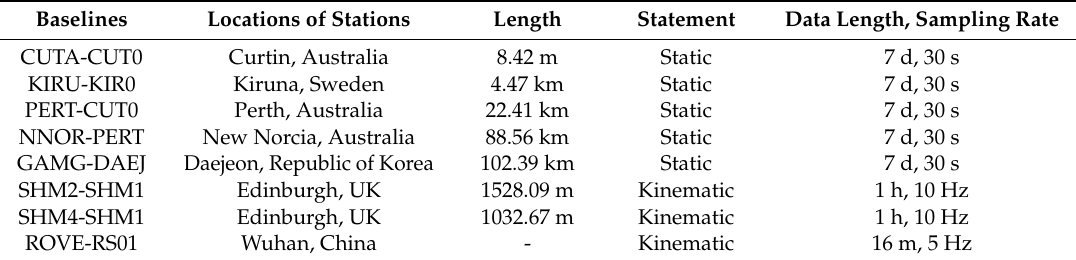
Table 1. Experimental baseline